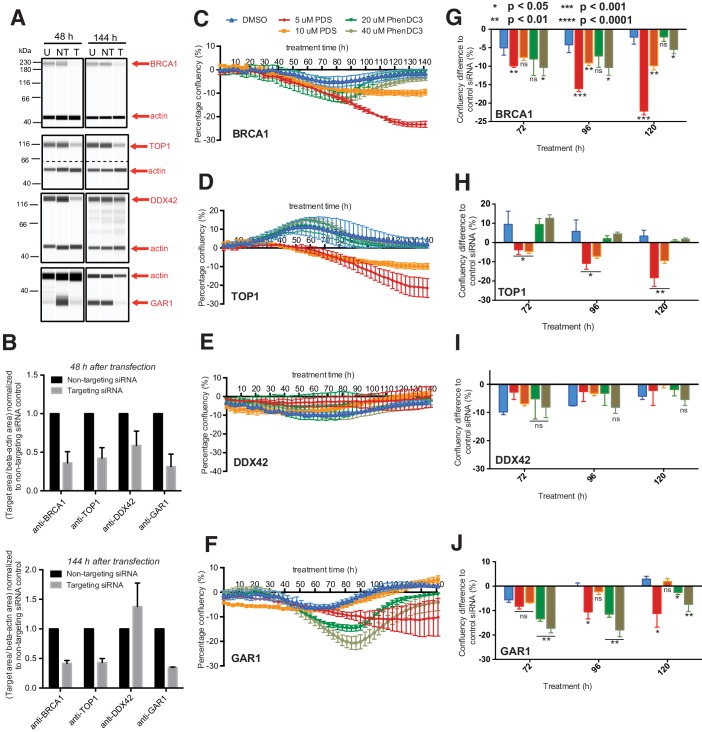
Short-term siRNA knockdowns validate four key sensitivities from the shRNA screening in A375 cells.(A) For BRCA1, TOP1, DDX42 and GAR1, A375 cells were transfected with non-targeting (NT) or targeting (T) siRNAs. 48 hr and 144 hr after transfection, lysates were probed appropriate antibodies alongside a non-transfected lysate (U). (B) BRCA1, TOP1, DDX42 and GAR1 protein levels for targeting (T) and non-targeting (NT) lysates were normalised to the internal actin control and then normalised to NT levels for three independent blots 48 hr (top) and two independent blots 144 hr (bottom) after transfection (mean ± standard deviation). (C–F) A375 cells were transfected with the targeting siRNAs for 24 hr before PDS, PhenDC3 or DMSO treatment. Average confluency difference (mean ± standard deviation) compared to NT siRNA plotted across three replicates for (C) BRCA1, (D) TOP1, (E) DDX42, (F) GAR1. Confluency differences at 72, 96 and 120 hr plotted for comparison for (G) BRCA1, (H) TOP1, (I) DDX42, (J) GAR1.10.7554/eLife.46793.016Figure 8—figure supplement 3—source data 1.Source files for western blots.(A) Full length western blots and (B) capillary traces obtained from Compass Software (Simple Western) for results shown in Figure 8—figure supplement 3A.